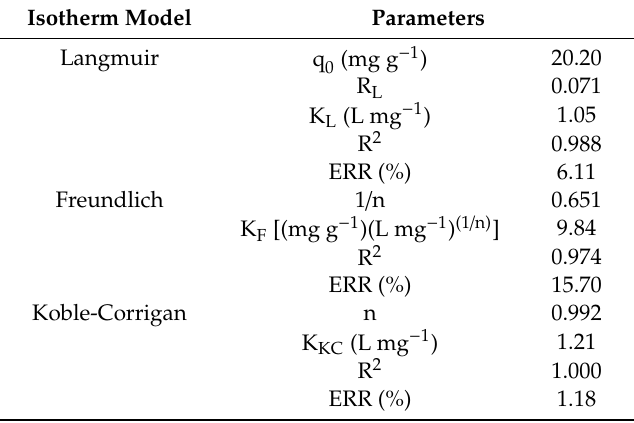
Table 3. The isotherm parameters for the adsorption of RR120 on the